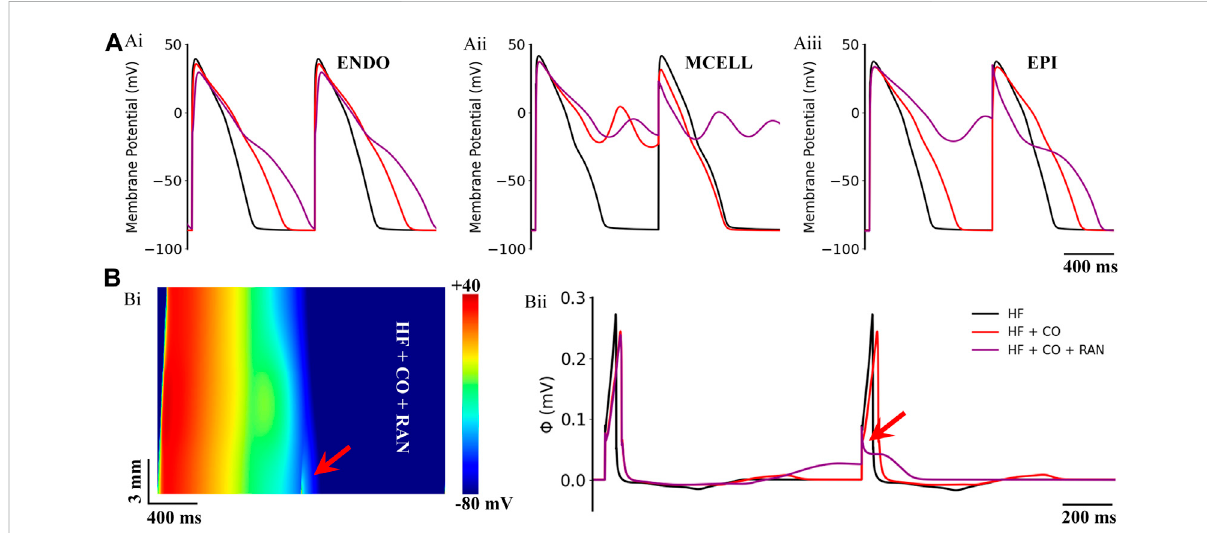
FIGURE 8 Actions of ranolazine (RAN) on CO-affected myocardial cells and tissues accompanied by heart failure (HF). (A) The comparison of action potentials of three cell types under ‘ HF ’ , ‘ HF + CO ’ , and ‘ HF + CO + RAN ’ conditions. (B) Spatial-temporal plots under the ‘ HF + CO + RAN ’ condition (Bi), and the corresponding pseudo-ECGs (Bii).